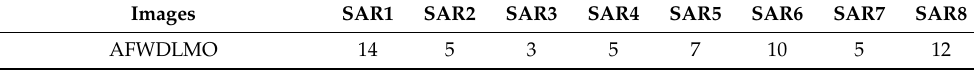
Table 3. Feature weights obtained by AFWDLMO on eight SAR